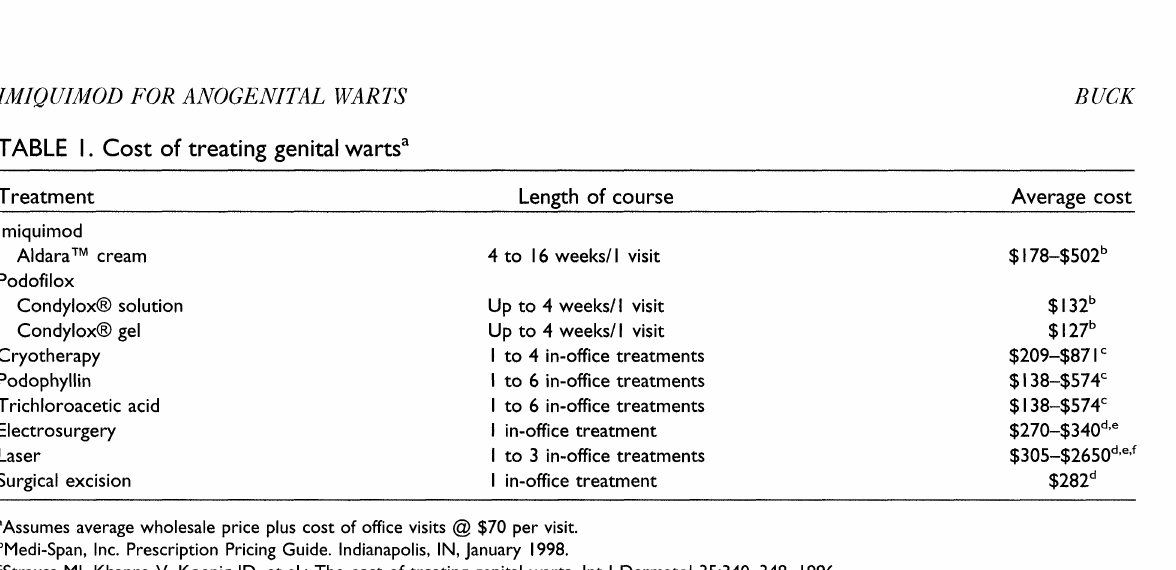
represents the average cost of